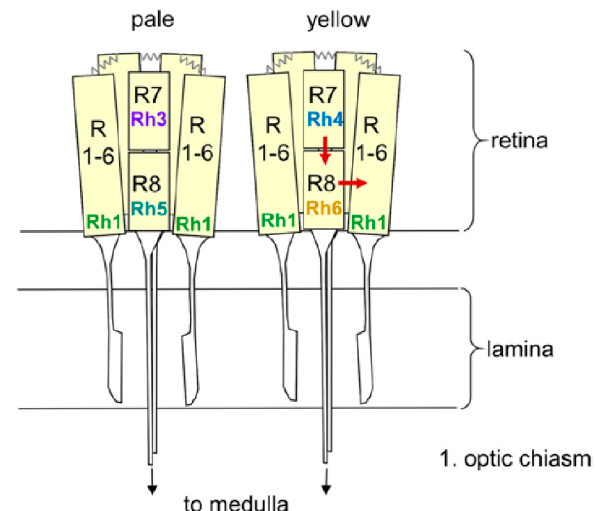
Figure 1. Schematic drawing of two ommatidia (pale and yellow) with detailed view of the eight receptor cells and their Rhodopsin expression. The outer receptor cells 1 to 6 (R1–6) span the entire depth of the retina, whereas the inner receptor cells R7 and R8 are arranged on top of each other. R1–6 terminate in the fly’s first optic neuropil, the lamina, whereas R7 and R8 run toward the medulla. R1–6 are connected via gap junctions (zigzag lines). The arrows indicate the putative interaction between the Rh6-expressing R8 cell and R1–6, as well as between R7 and R8 (from [40]).